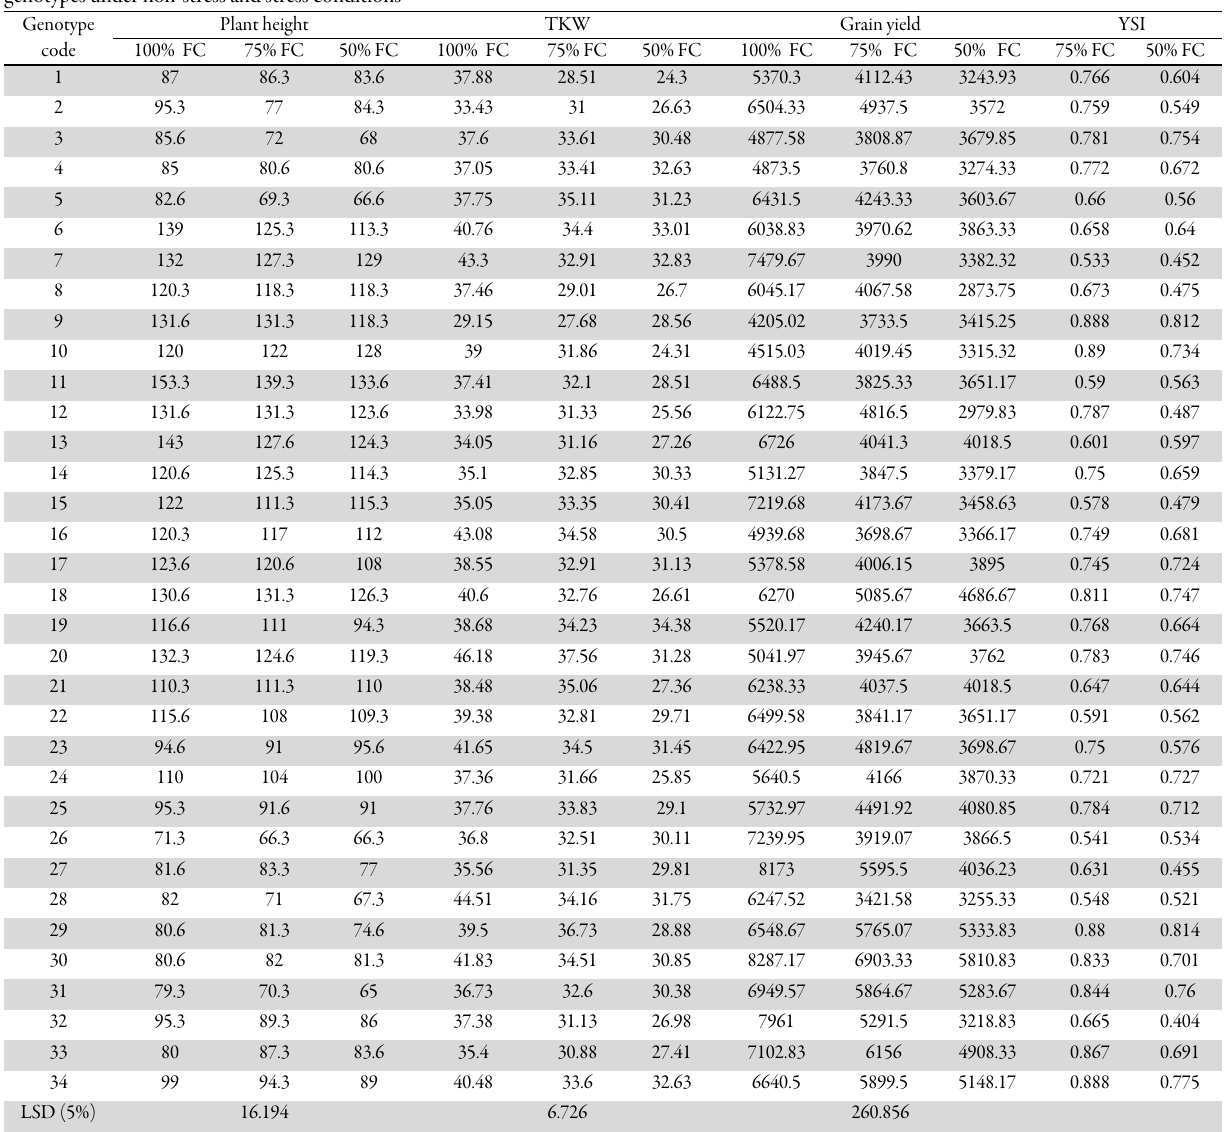
Table 5. Average plant height (cm), TKW thousand kernel weight (g), grain yield (kg ha -1 ) and YSI (yield stability index) of 34 hexaploid wheat genotypes under non-stress and stress conditions Genotype